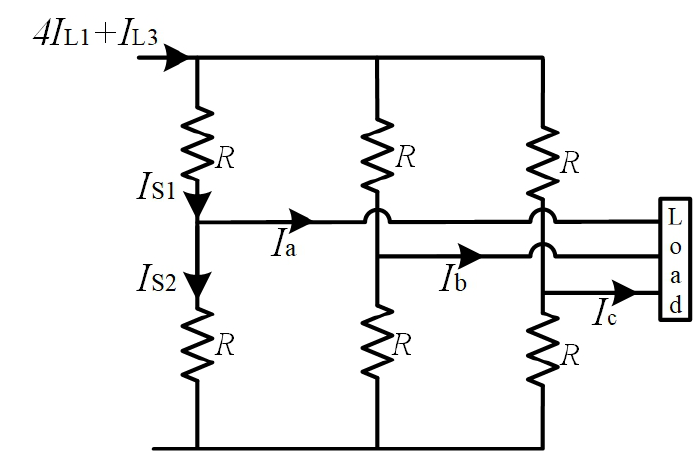
Figure 5. Inverter switching device power (SDP)